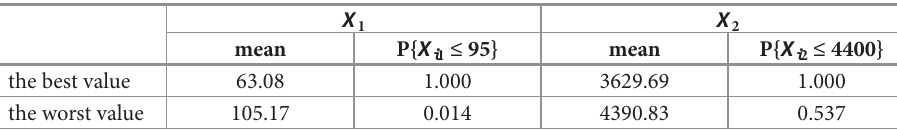
Table 4. Data presented to the decision maker at iteration 1